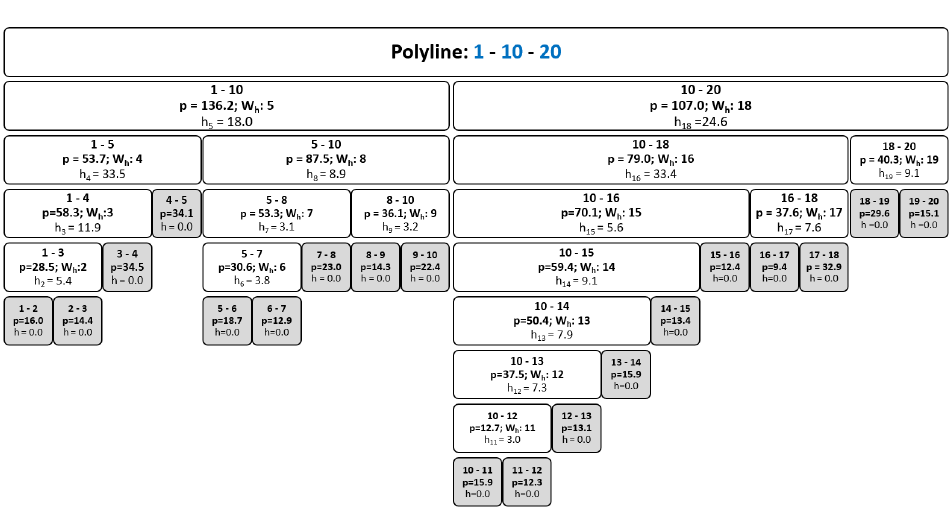
Fig. 3. Structure of the binary tree of an ordered polyline L